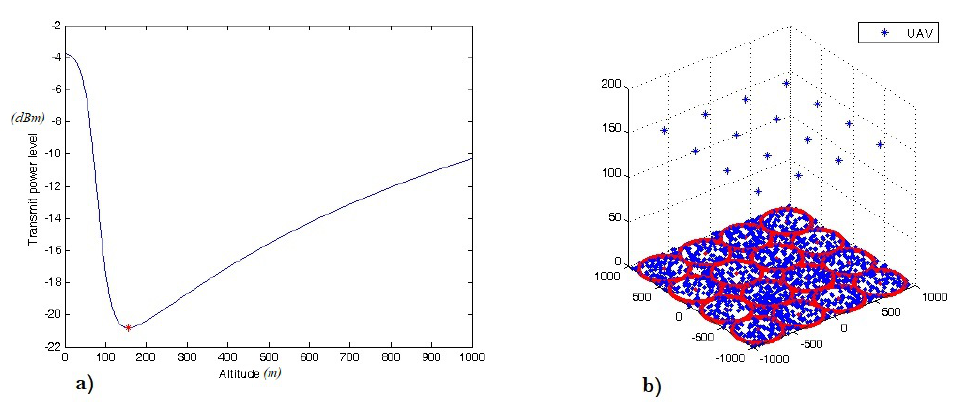
Figure 6. ( a ) The optimal UAV altitude is at 156 m; ( b ) the optimal placement of 16 UAVs with a circle radius of 250 m, when n =